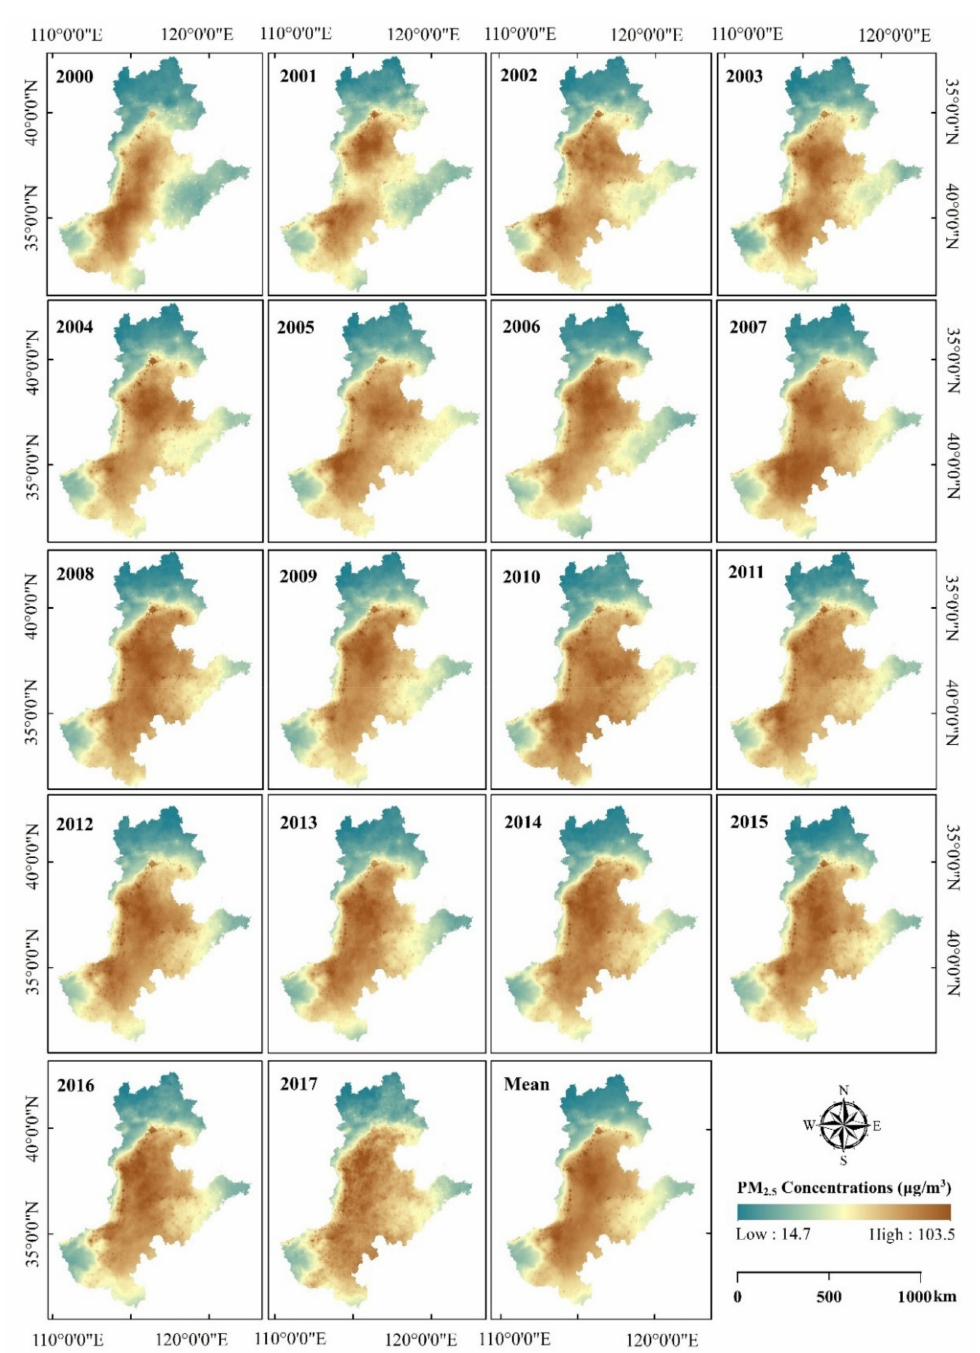
Figure 2. Spatiotemporal evolution of the annual mean PM 2.5 concentrations from 2000–2017 in North China (data source: http://fizz.phys.dal.ca/~atmos/martin/ accessed on 20 May 2020). Based on the results of previous studies, the explanatory variables used in this study were: population density (PD), industrial output (IO), number of industries (NI), road density (RD), fossil fuel combustion (FC), and proportion of the non-agricultural population (UR) (Table 1). The UR is a traditional and commonly used proxy to represent urbanization. Additionally, the road data calculated in this study were obtained from Open Street Map [36], which maps urban roads and multi-segment highways. The line density tool in ArcGIS was then used to calculate RD in each city of the study area from 2000 to